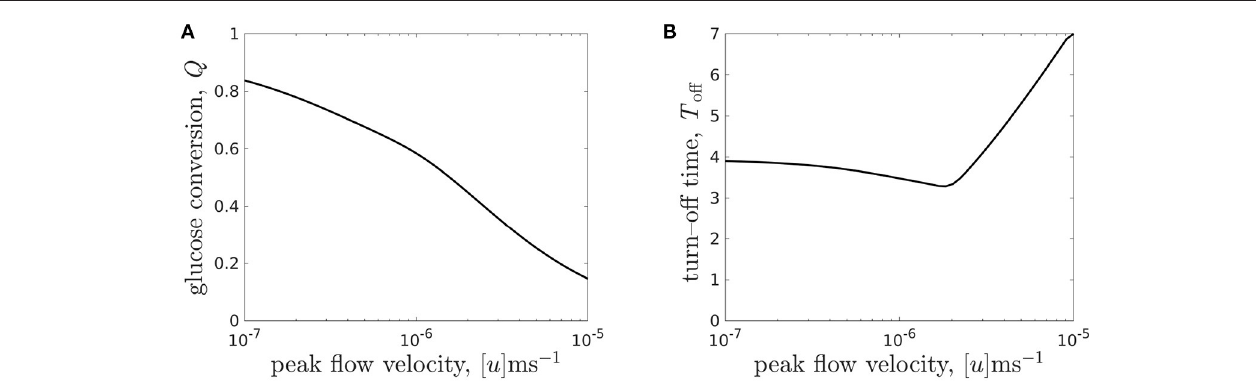
FIGURE 9 | (A) Glucose conversion Q , Equation (3.3), at time T = 7 and (B) turn-off time T off (the time when intolerable lactate levels first experienced) for the CXP1 bioreactor varying with flow rate, for a given organoid line. Peak flow velocities [ u ] ∈ µ ∈ [ 0.096,9.6 ] and the other parameter values are given in Table 3